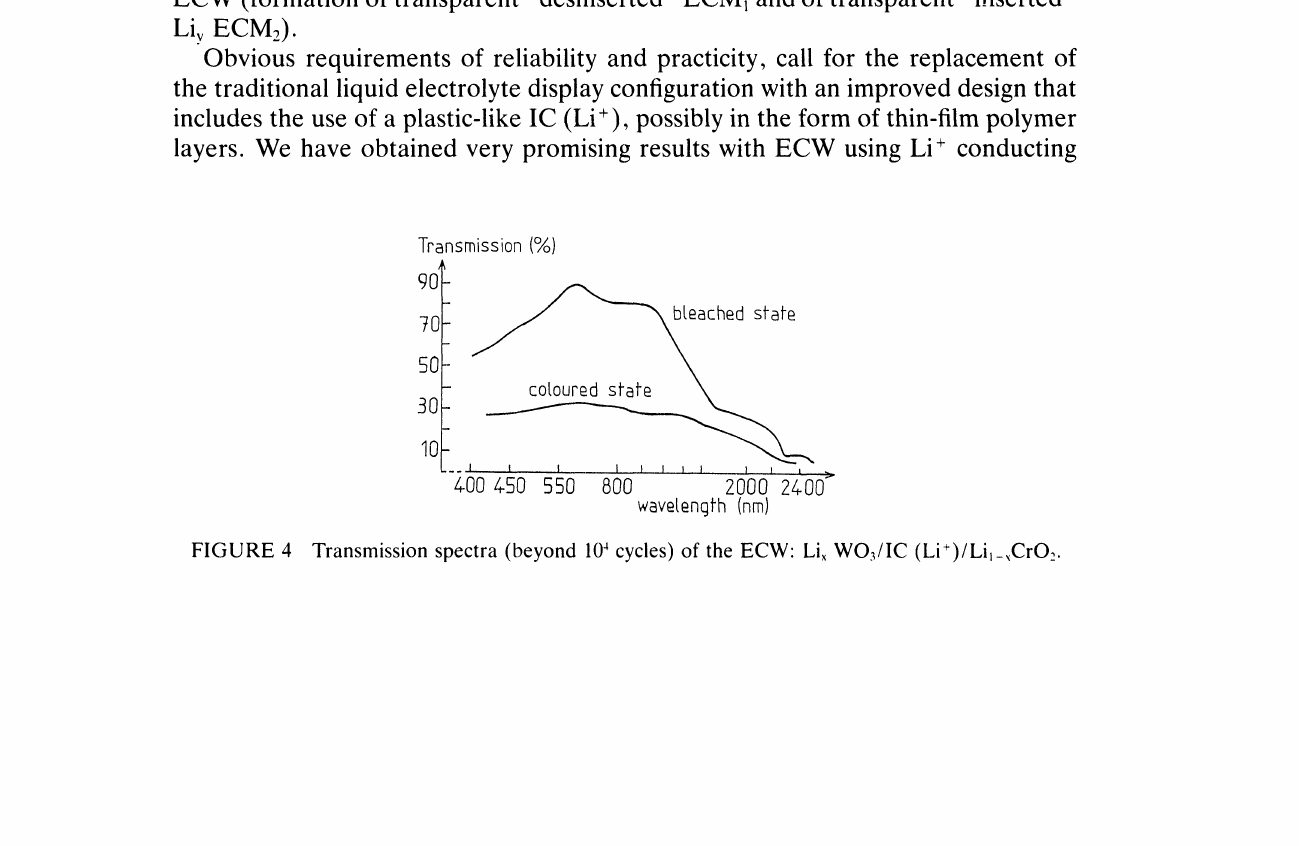
FIGURE 3 Transmission (2 550 nm) vs time, for repeated colouring and bleaching cycles, of the ECW" Li, WO3/IC (Li +)/Li_xCrO_,. ation by cathodic polarization of ECM1 (formation of colored "inserted" Lix ECMI)